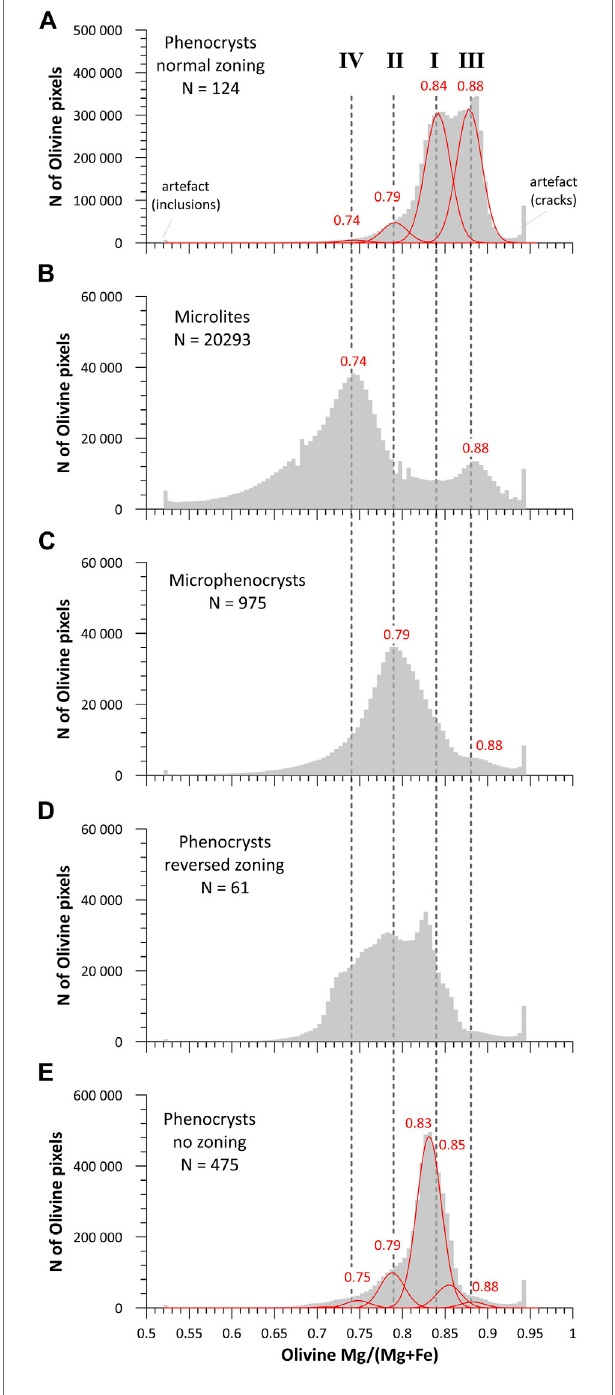
FIGURE 12 | Histograms showing distribution of olivine compositions ( mg# ) for fi ve automatically classi fi ed groups: Phenocrysts with normal (A) , reversed (D) and “ no zoning ” (E) zoning, microlites (B) and microphenocrysts (C) . Mg# distributions in (A) and (E) were de-convoluted to highlight the presence of hidden compositional populations which exist in all crystal generations. See text for